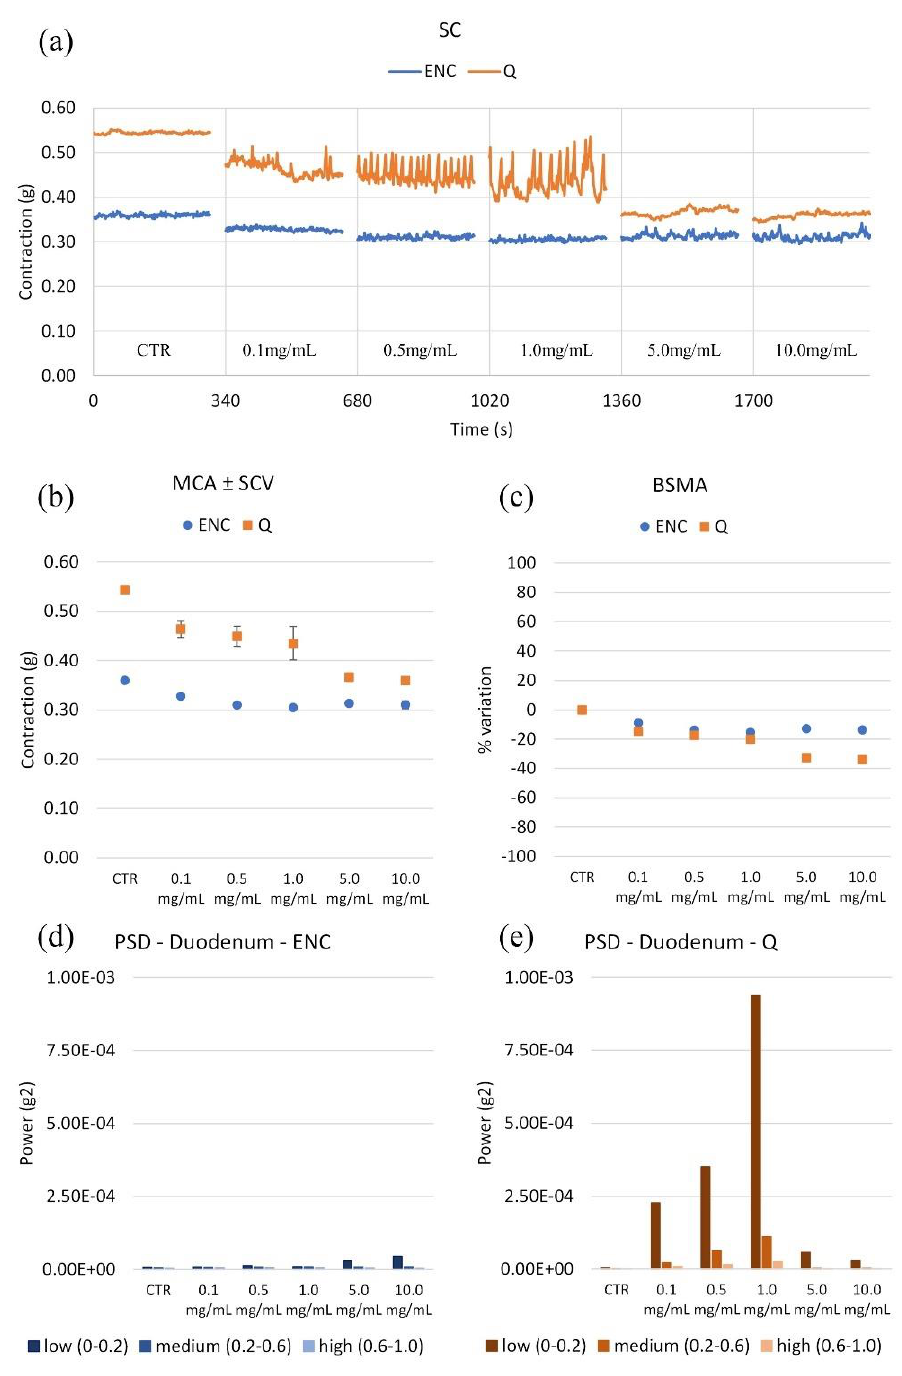
Figure 3. ( a ) Experimental original recording of the concentration–response curve of ENC ( Castanea sativa Mill.) and Q ( Schinopsis balansae Engl.) extract on duodenum spontaneous contractility (SC). ( b ) Mean contraction amplitude (MCA) with spontaneous contraction variability (SCV). ( c ) Basal Spontaneous Motor Activity (BSMA). Zero represents the basal tone, and each point is the percent variation from the baseline after cumulative addition of each dose; each value is the mean ± SEM; when the error bar is not shown, it is covered by the point. Power Spectral Density (PSD): ( d ) Duodenum with ENC; ( e ) Duodenum with Q.